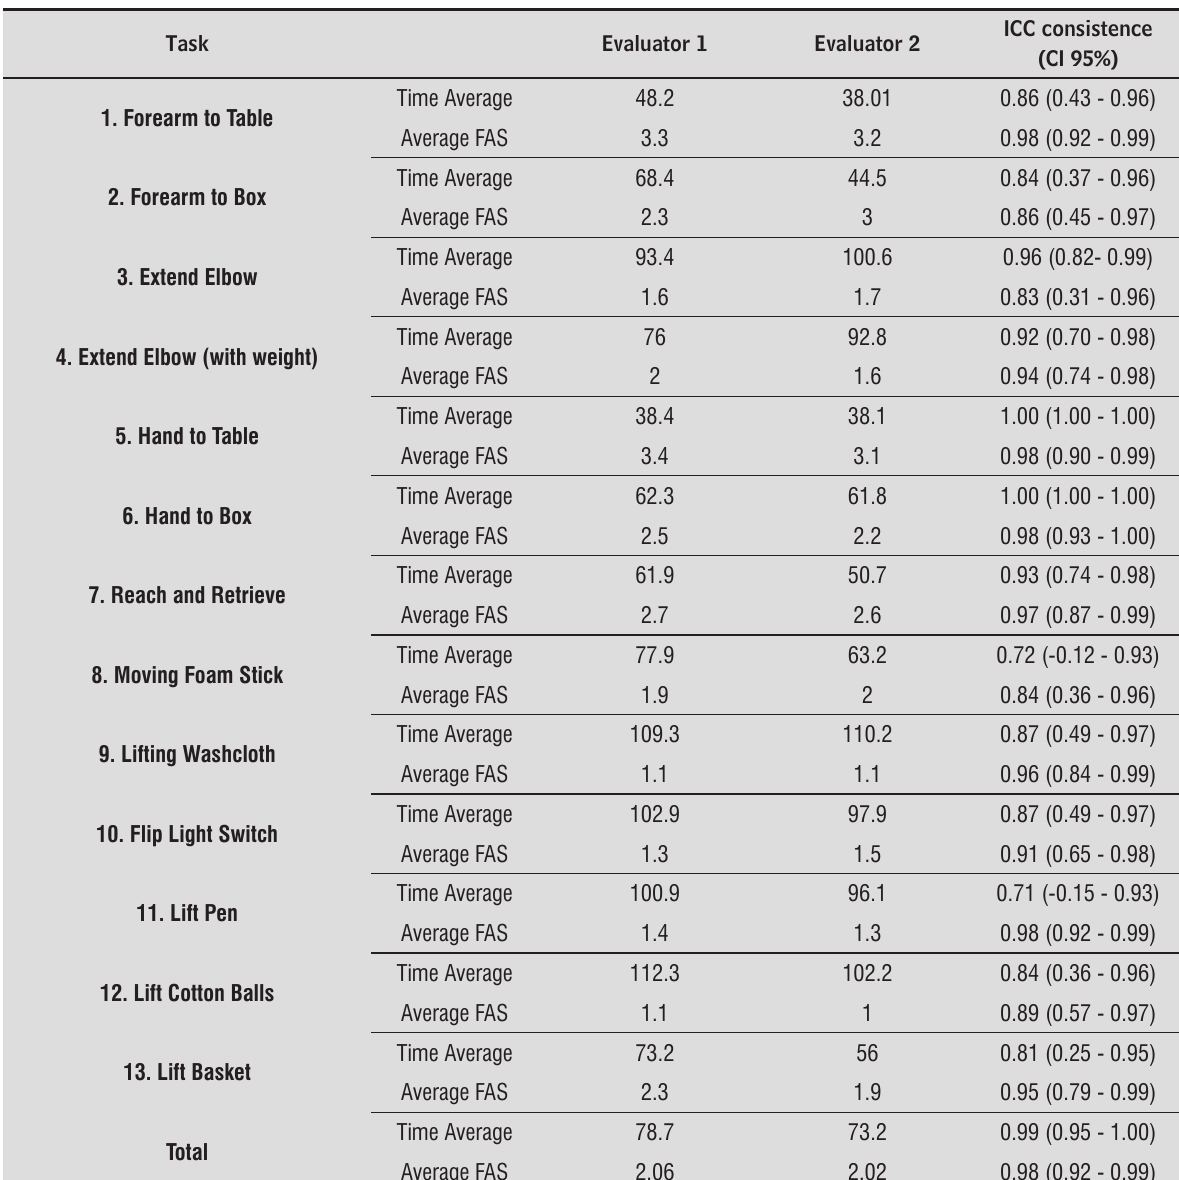
Table 2 - Inter-rater Reliability for the Application of GWMFT